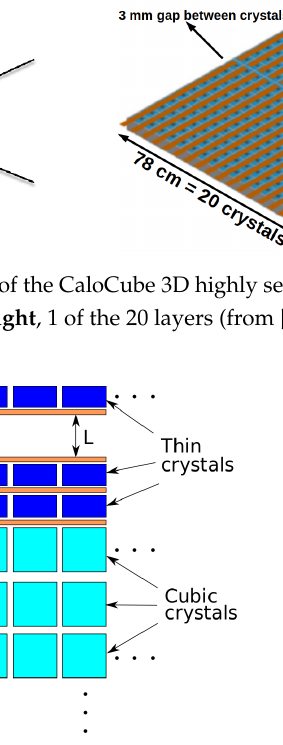
Figure 3. Schematic side view of the upper face of the simulated TIC: on the top, 3 scintillator layers made of thin crystals (blue) plus 4 silicon microstrip layers (orange) interleaved in; on the bottom, some layers made of cubic crystals (cyan) from CaloCube (from